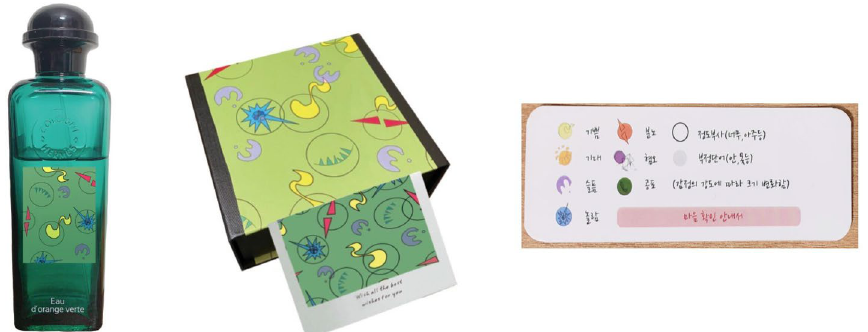
Fig. 8 Perfume series effect diagram and the card illustration for reading the emotional message